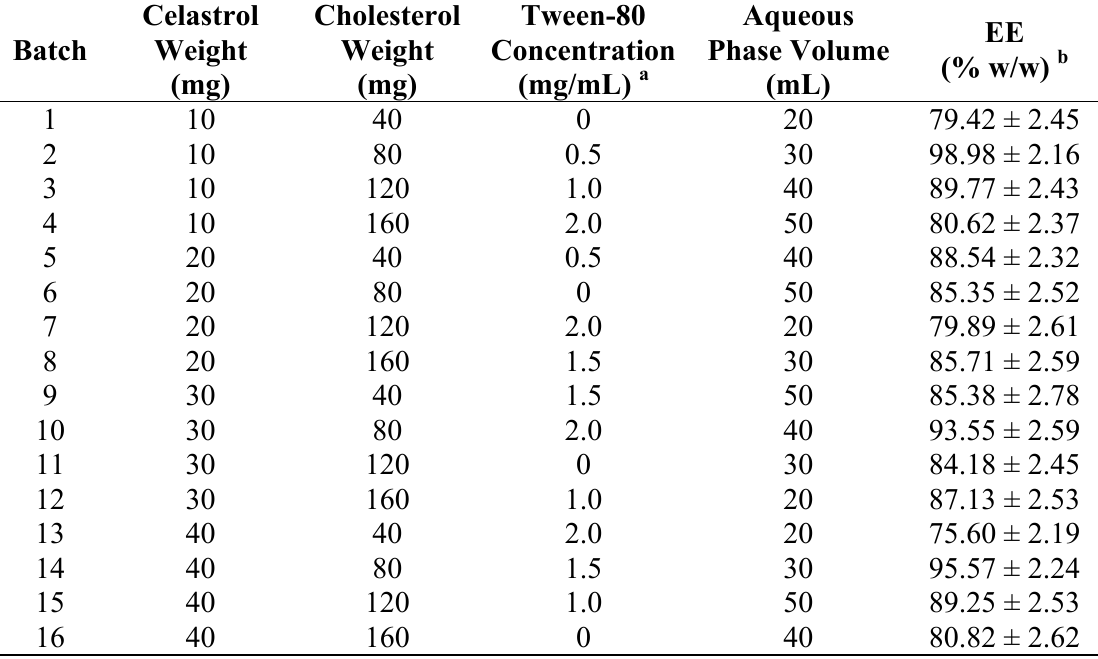
Table 3. Encapsulation efficiency of different batches of celastrol–loaded liposomes prepared using the ethanol injection method. Batch